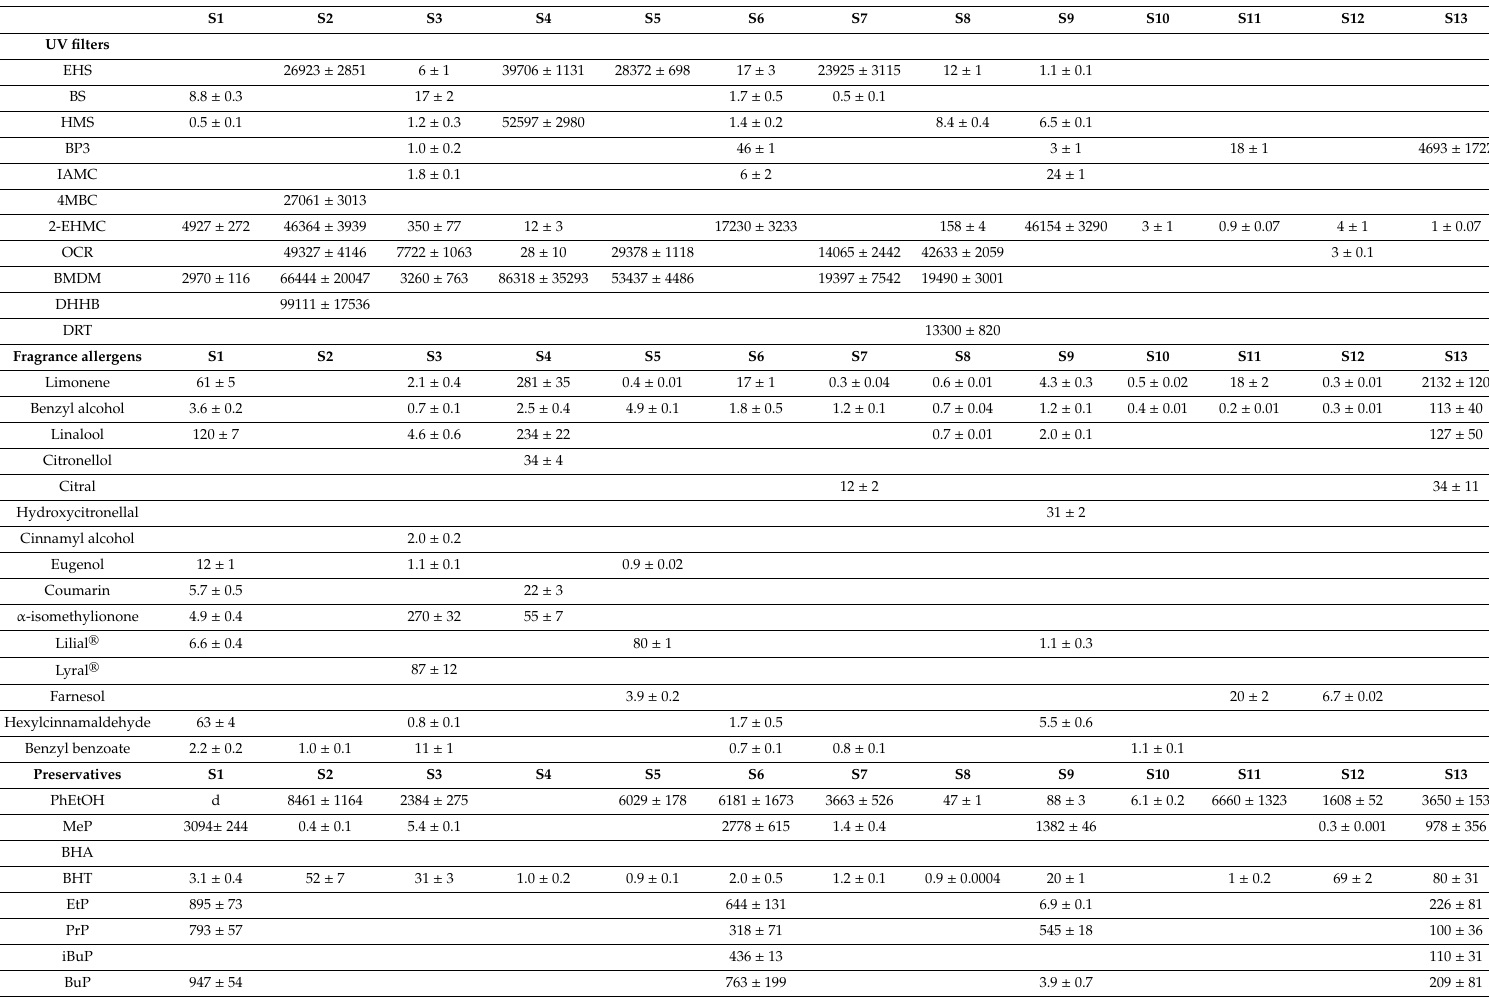
Table 6. Concentration of the UV filters and the other personal care products (PCPs) ( µ g g − 1 equivalent to × 10 4 %w /